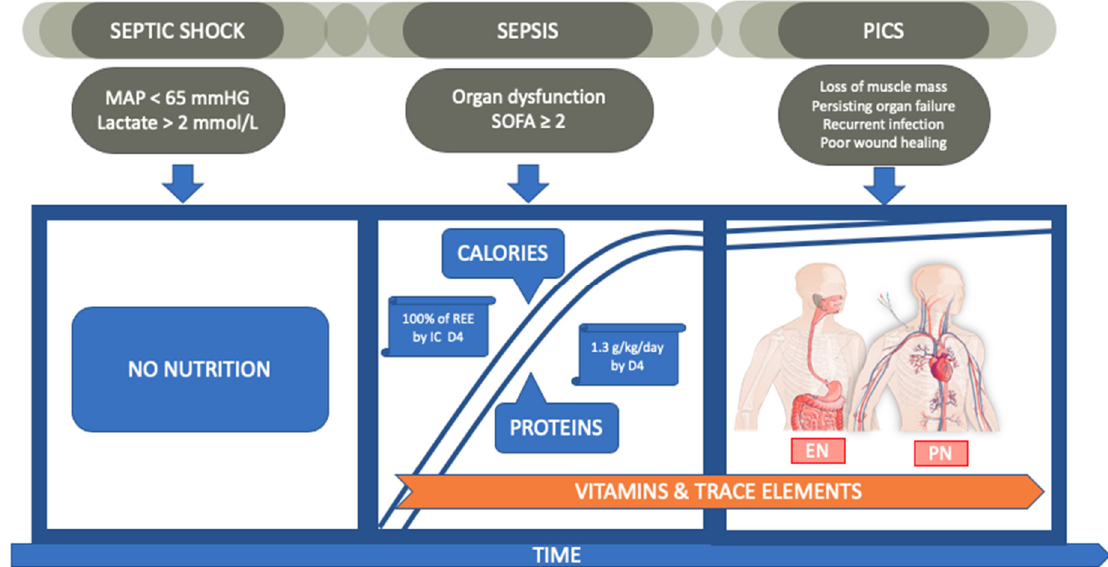
Figure 1. Flow Visual representation of nutritional therapy in sepsis. Mean Arterial Pressure (MAP); Sequential Organ Failure Assessment (SOFA); Post Intensive Care Syndrome (PICS); resting energy expenditure (REE); indirect calorimetry (IC); Day 4 (D4); enteral nutrition (EN); parenteral nutrition (PN).